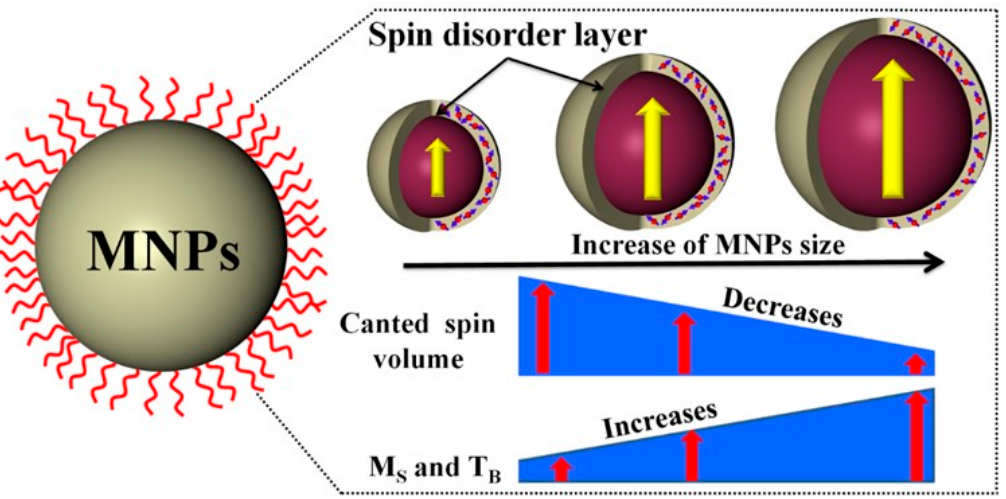
Figure 7. Schematic representation of the variation of spin-canting effect, saturation magnetization, and blocking temperature with the MNPs size.